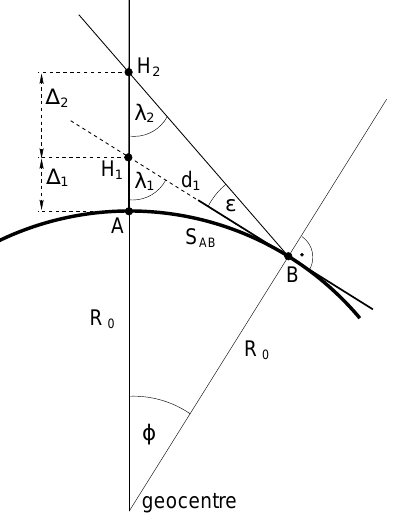
Fig. 1. Idealised geometry used to estimate the altitude of intersec- tion